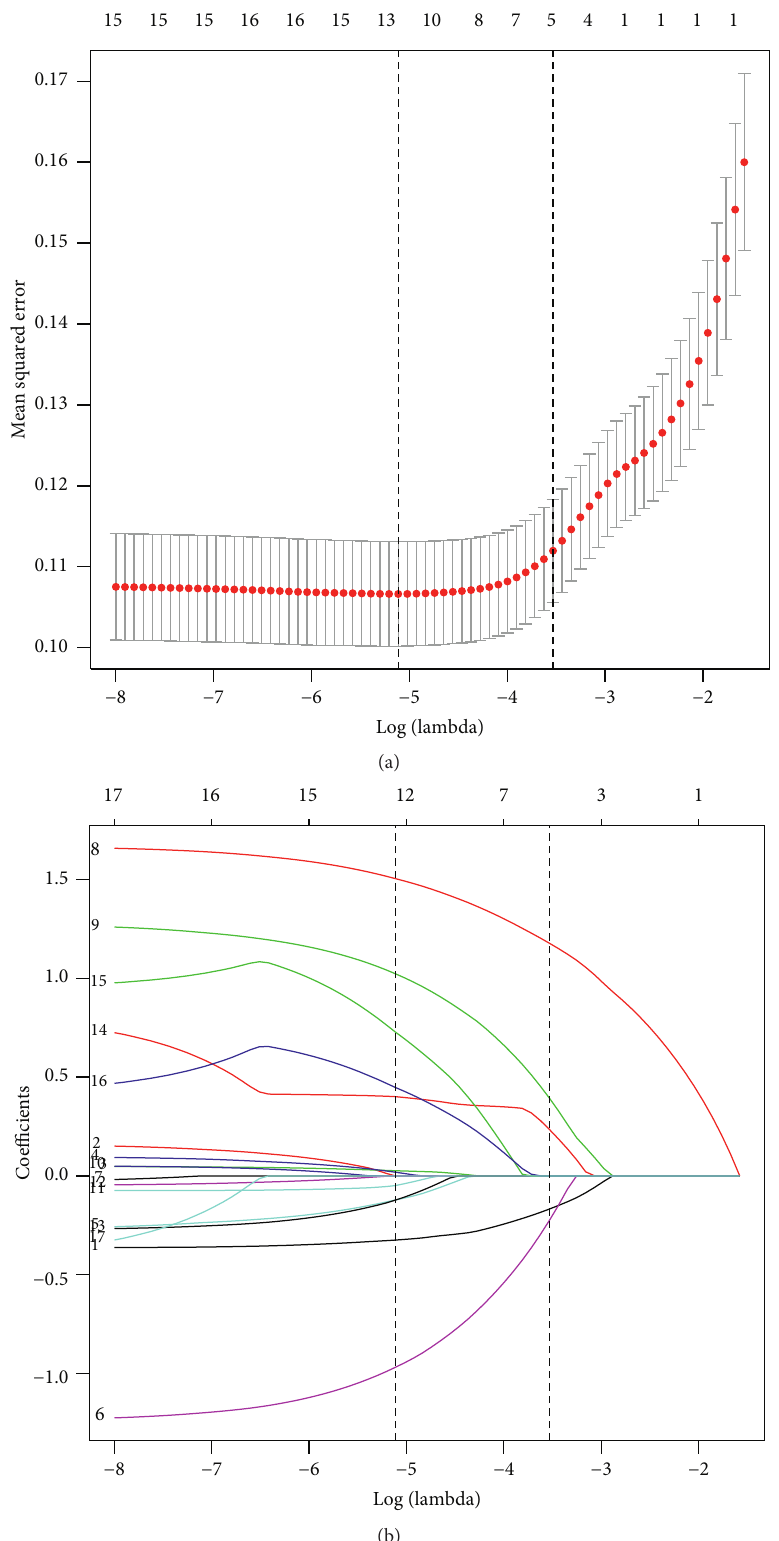
Figure 2: Demographic features, socioeconomic status, live setting, health-related behaviors, and anthropometric value selection using the LASSO binary logistic regression model. (a) Optimal parameter (lambda) selection in the LASSO model used fivefold cross-validation via minimum criteria. The partial likelihood deviance (binomial deviance) curve was plotted versus log (lambda). Dotted vertical lines were drawn at the optimal values by using the minimum criteria and the 1-SE of the minimum criteria (the 1-SE criteria). (b) LASSO coefficient profiles of the 17 features. A coefficient profile plot was produced against the log (lambda) sequence. Vertical line was drawn at the value selected using fivefold cross-validation, where optimal lambda resulted in five features with nonzero coefficients. LASSO: least absolute shrinkage and selection operator; SE: standard